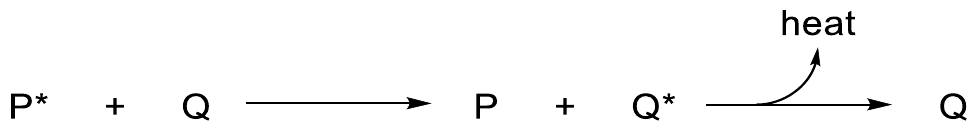
Figure 5. UV absorbers act as quenchers for the excited state energy of polymers. * Represents the excited state.